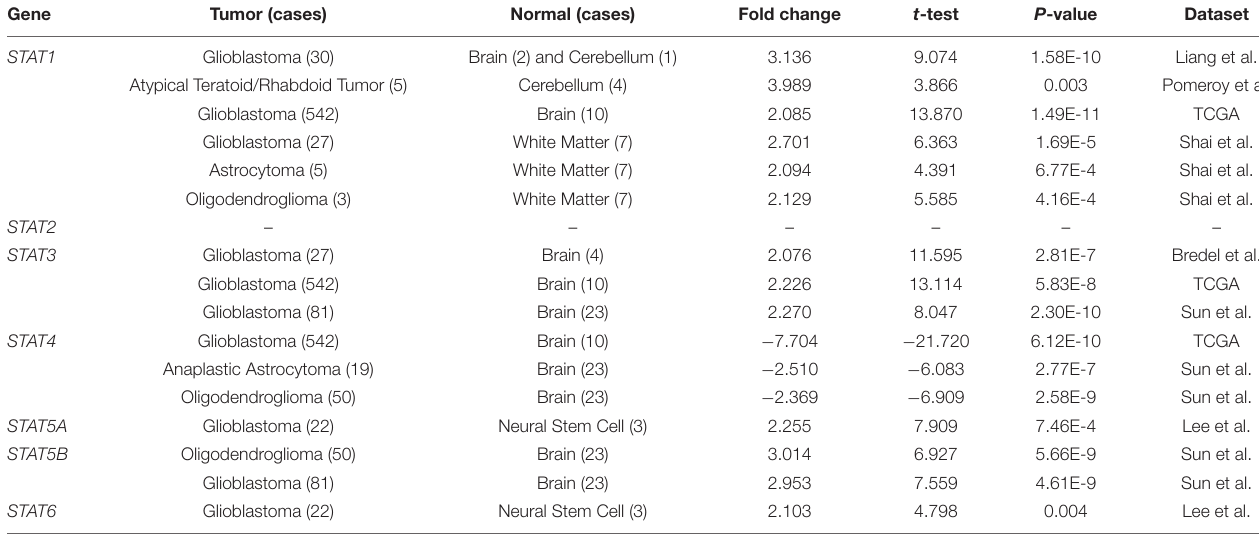
TABLE 1 | Datasets of STAT family genes in glioma (Oncomine).